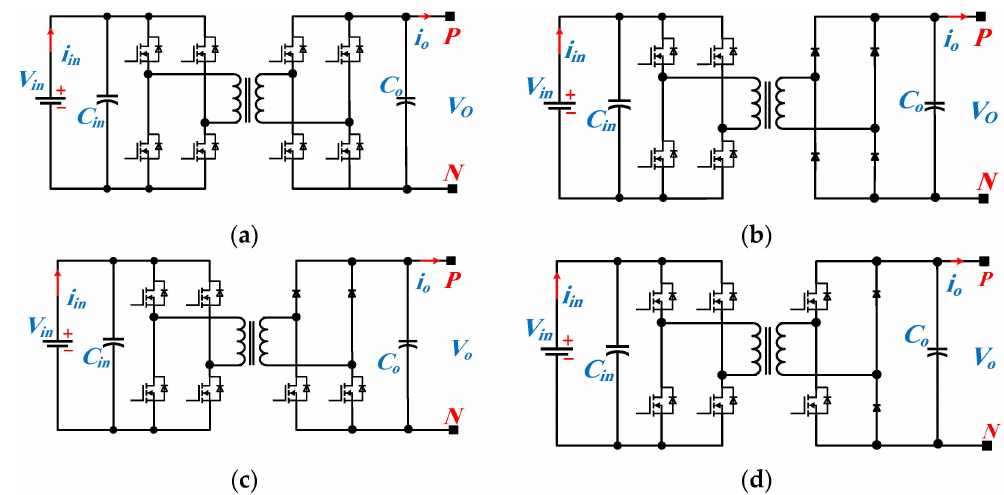
Figure 17. Other SM topologies ( a ) DAB [94], ( b ) SAB [101], ( c ) Semi-DAB [102], and ( d ) F-DAB